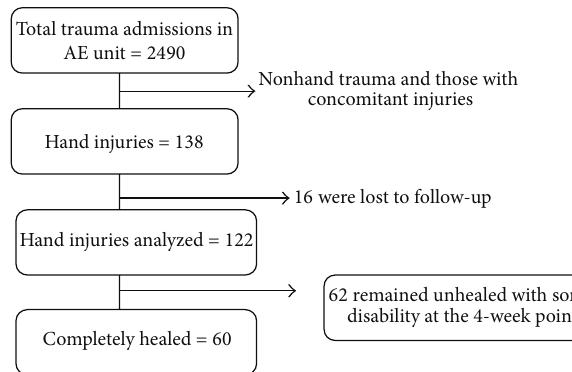
Figure 1: Flow chart patients seen in Accident and Emergency Department from October 2006 to February 2007 at Mulago National Referral